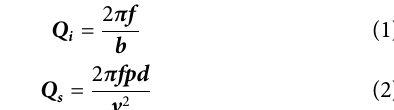
Frontiers in Earth Science |